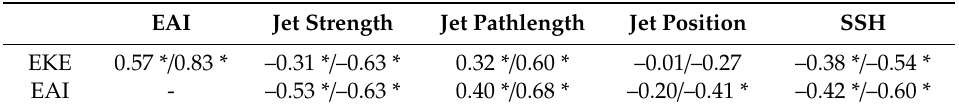
Table 1. Correlation coe ffi cients between the EKE, EAI, and other existing KE indices: jet strength, pathlength, position, and SSH index with the monthly / annual